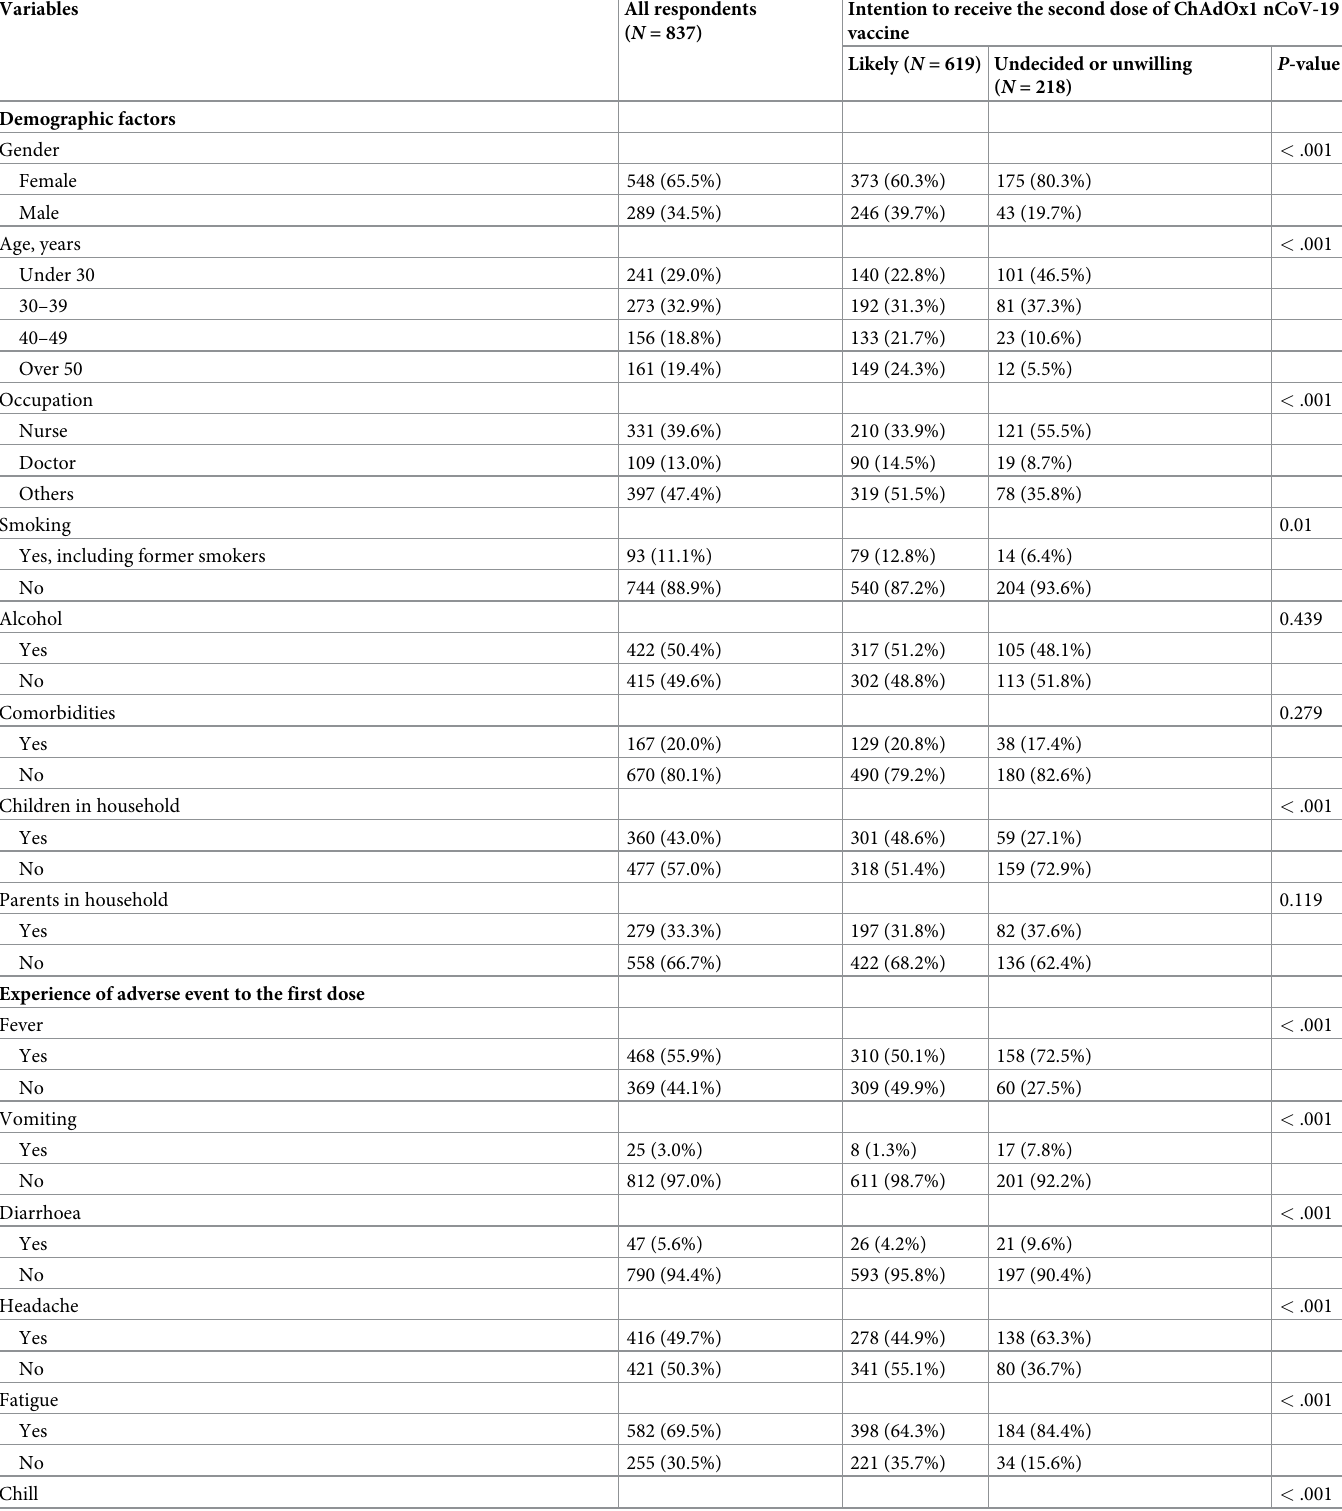
Table 1. Characteristics of healthcare workers who had received the first dose of ChAdOx1 nCov-19 vaccine in the